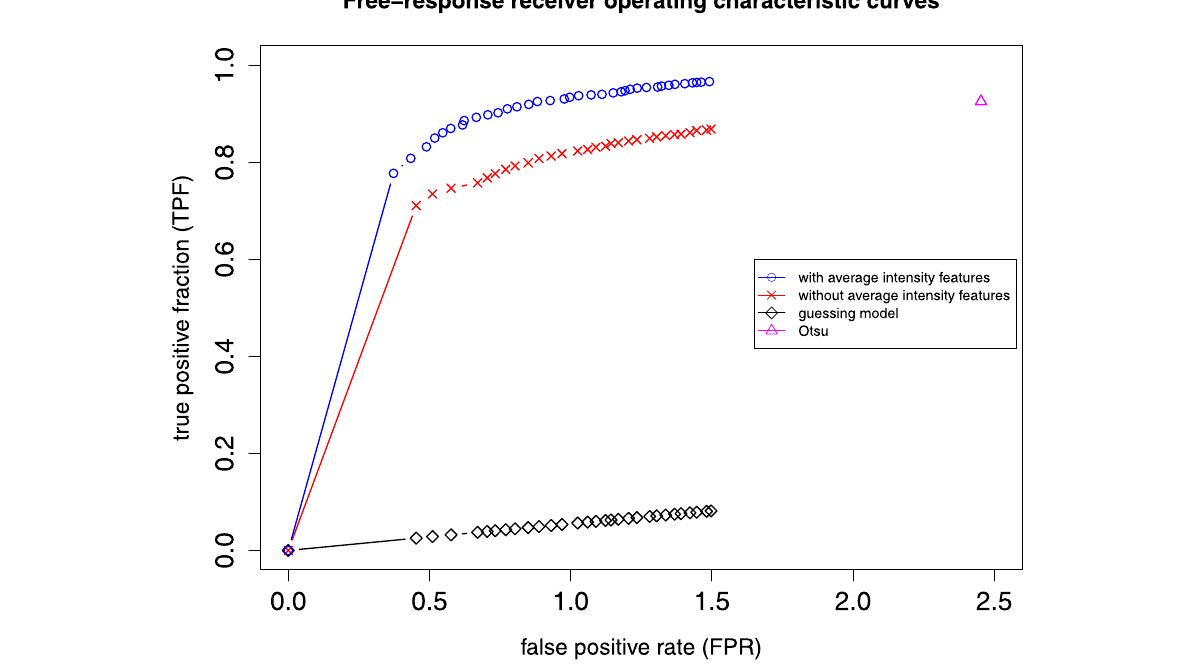
Fig. 5 FROC curves for the detection and localization of parasites